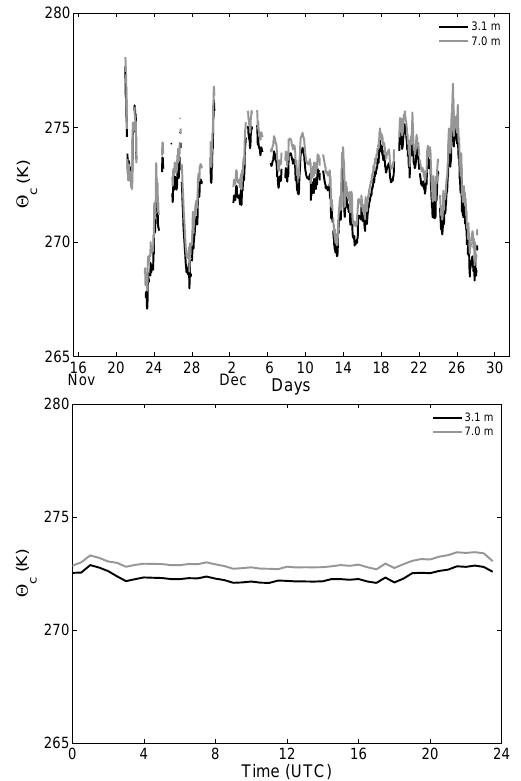
Fig. 1. Time-series (left panel) and diurnal cycle (right panel) of potential (sonic) temperature observed during the ISCAT 2000 field campaign.